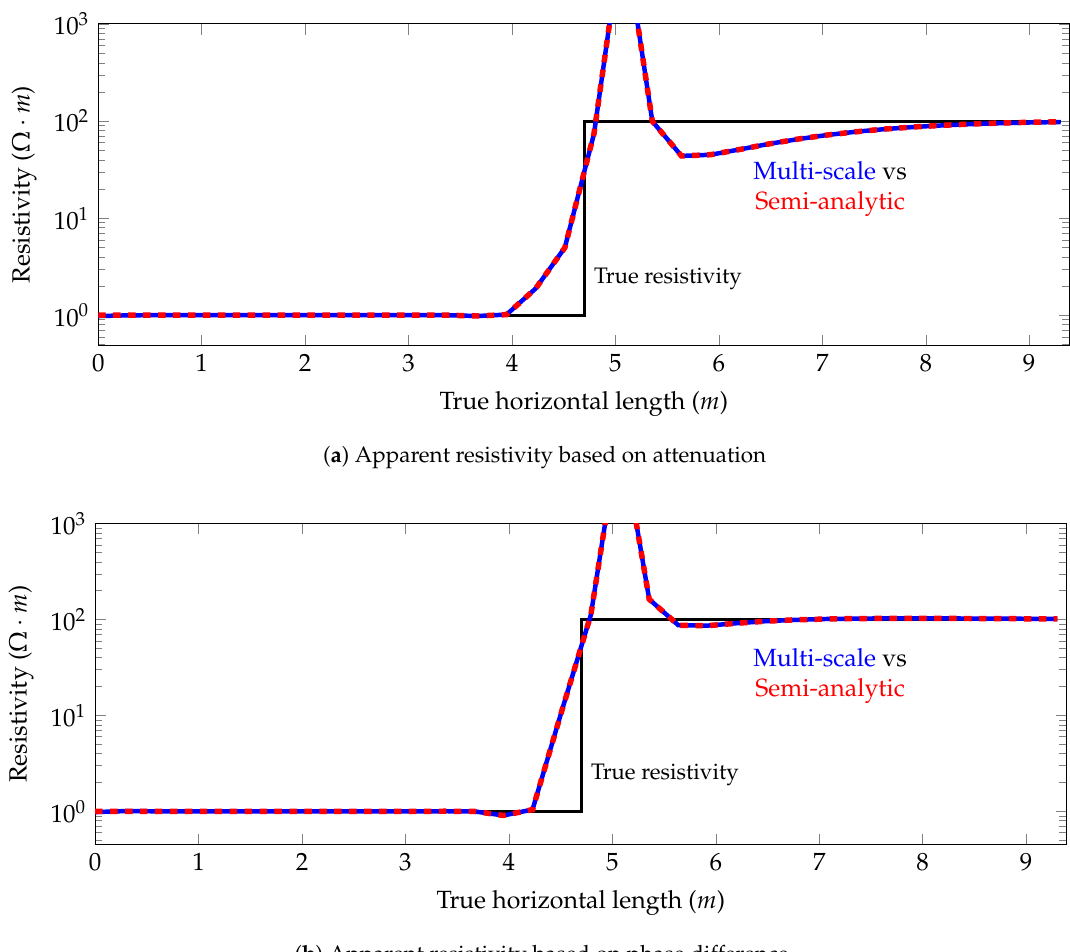
Figure 8. Model problem 1. Apparent resistivity for the zz coupling for a 70 ◦ deviated